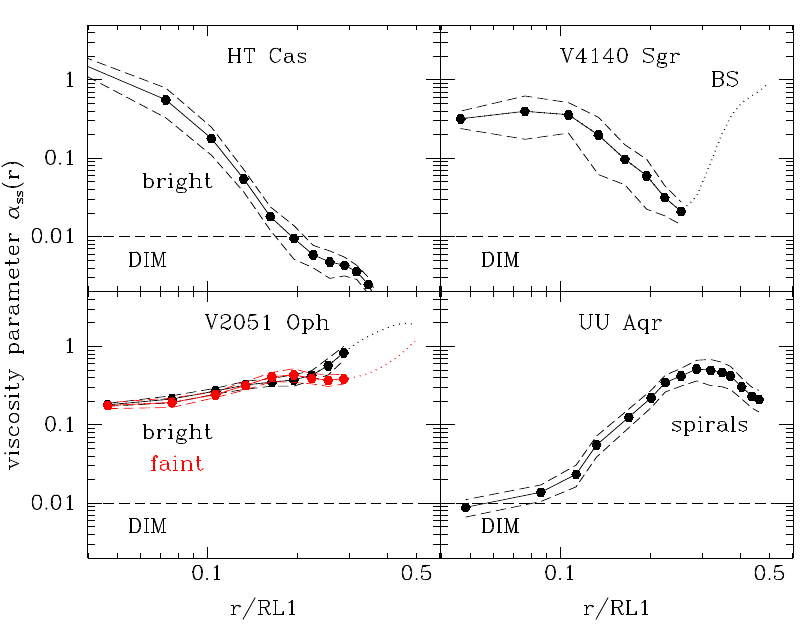
Figure 2: The radial run of the disc viscosity parameter inferred from disc flickering relative amplitude distri- butions, for three strong flicker DNs and for the nova-like variable UU Aqr. Dots with solid line show average α ss values, while dashed lines indicate their 1- σ limits. Horizontal dashed lines depict the typical α cool = 10 − 2 value expected for quiescent DN discs according to